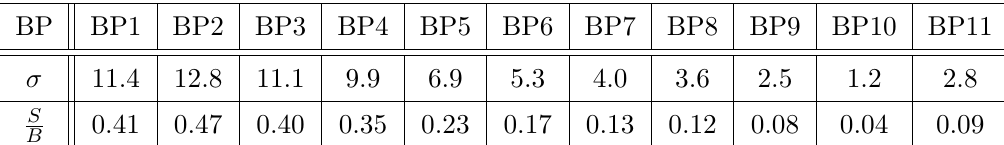
Table 5. Statistical significance ( σ ) and the signal-to-background ratio ( S corresponding to different benchmark points contributing to the fatjets + /E LHC and 139 fb − 1 integrated